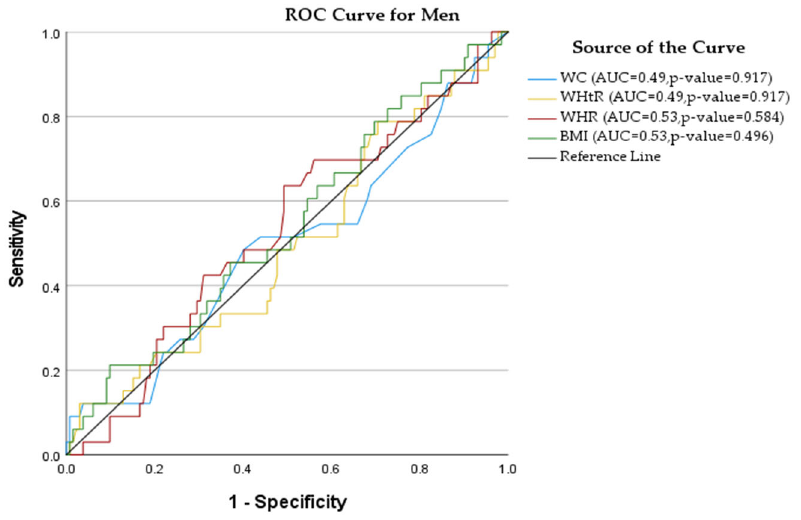
Figure 2. ROC curves for men presenting the relationship between obesity indicators and elevated DBP ( ≥ 90 mmHg).